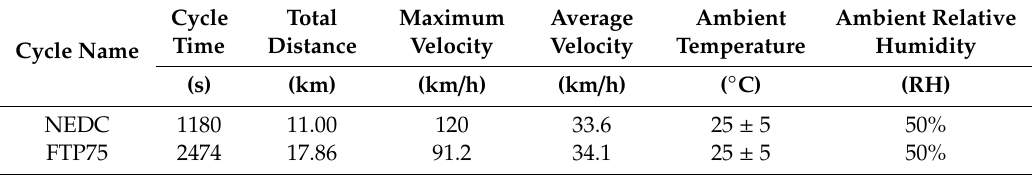
Table 2. Comparison of the New European Driving Cycle (NEDC) and Federal Test Procedure (FTP75) driving cycles.